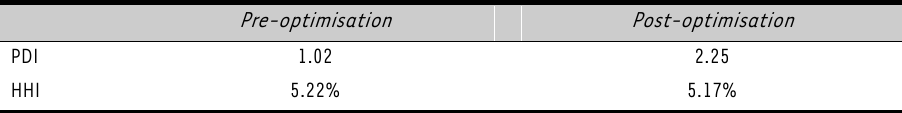
Comparative results